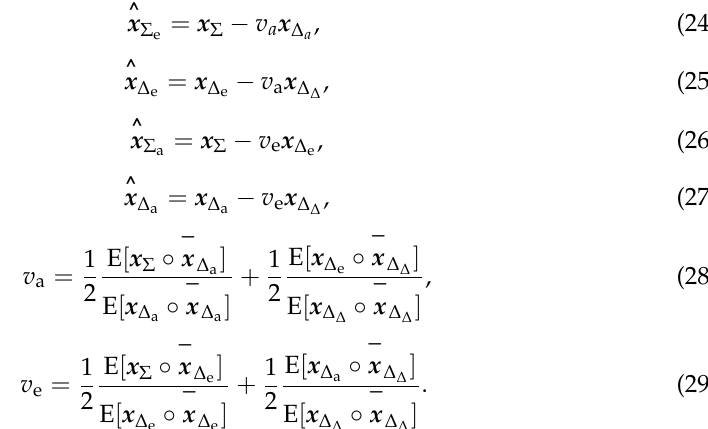
Figure 2. The principle of the MLC algorithm. The output signal of each channel of the monopulse antenna after MLC can be ex- pressed as